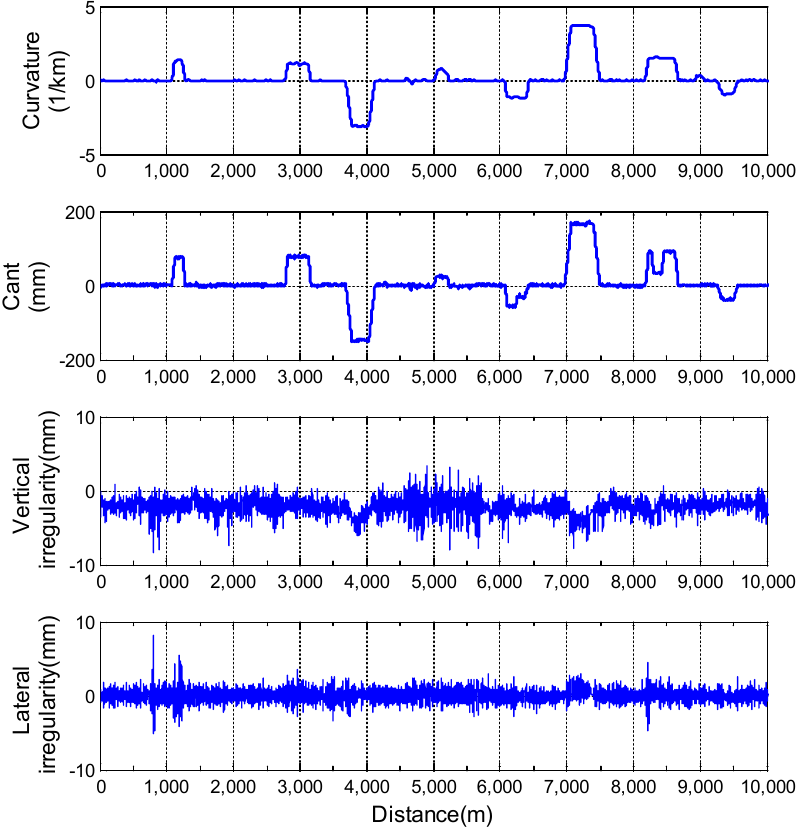
Figure 5. Track model for multibody dynamic simulation.